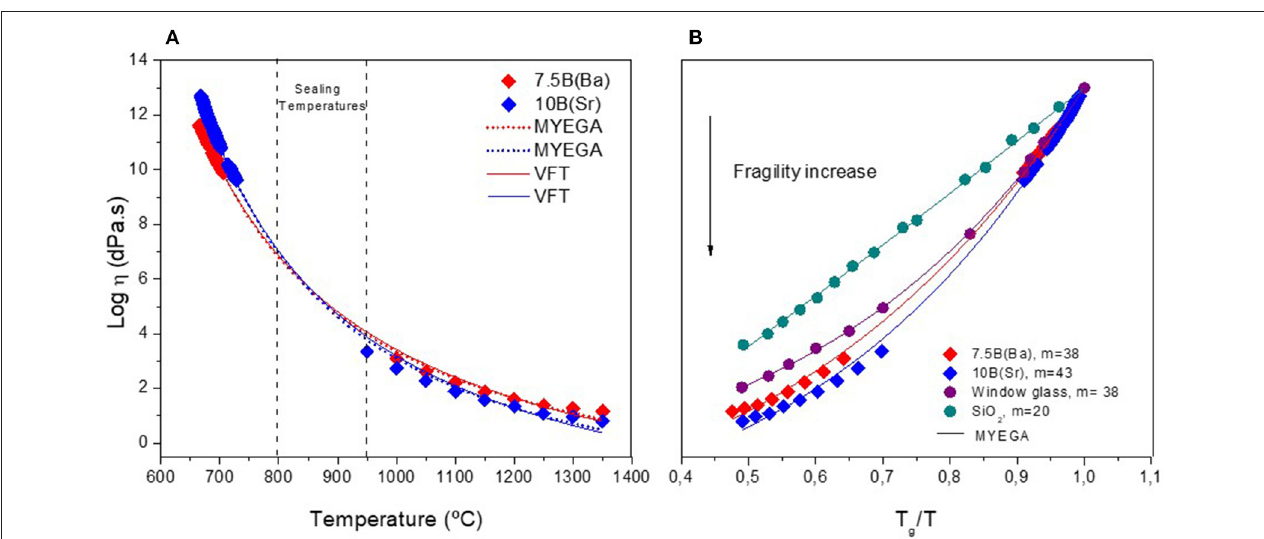
FIGURE 1 | (A) Viscosity-temperature curves for the glasses 7.5B(Ba) and 10B(Sr). Fit of the experimental points: VFT equation (continuous lines) and MYEGA equation (dot lines). (B) Viscosity curves vs. T g /T for the glasses 7.5B(Ba), 10B(Sr), window glass and silica, the continuous lines show the fit with MYEGA